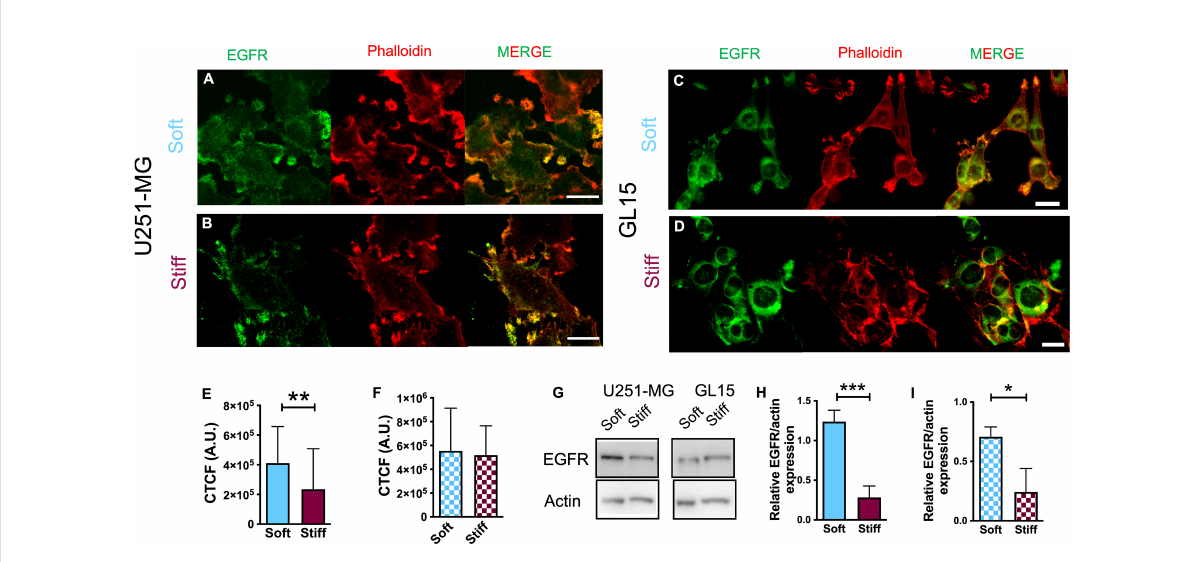
FIGURE 4 Decreased substrate stiffness stimulates EGFR expression in U251-MG. (A – D) Immuno fl uorescence images of U251-MG cells seeded on Soft (A) and Stiff (B) substrates and GL15 cells seeded on Soft (C) and Stiff (D) substrates. Cells were stained for phalloidin-TRITC (red), EGFR (green). Scale bar = 25 m m. (E, F) Quanti fi cation of fl uorescence intensity of EGFR (expressed as CTCF, see methods section) of U251-MG (E) and GL15 (F) cells seeded on substrates of different stiffnesses. (G) Representative western blots of total EGFR levels in cells cultured on substrates of different stiffness. (H , I) Quanti fi cation of the immunoblots of U251-MG (H) and GL15 (I) cells on substrates of different stiffnesses. The percentage changes in the normalized EGFR levels were calculated relative to the normalized intensity for the petri condition (not shown). Measurements are representative of four distinct sets of data. Data, denoted as mean ± S.D., are representative of at least three independent experiments. Student ’ s t-test was used for statistical analysis; *p < 0.05; **p < 0.01; *** p< 0.001.